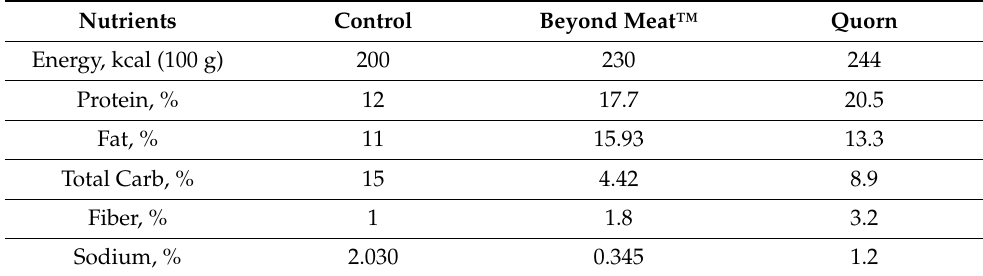
Table 7. Nutritional content of other burger patties [37,38].